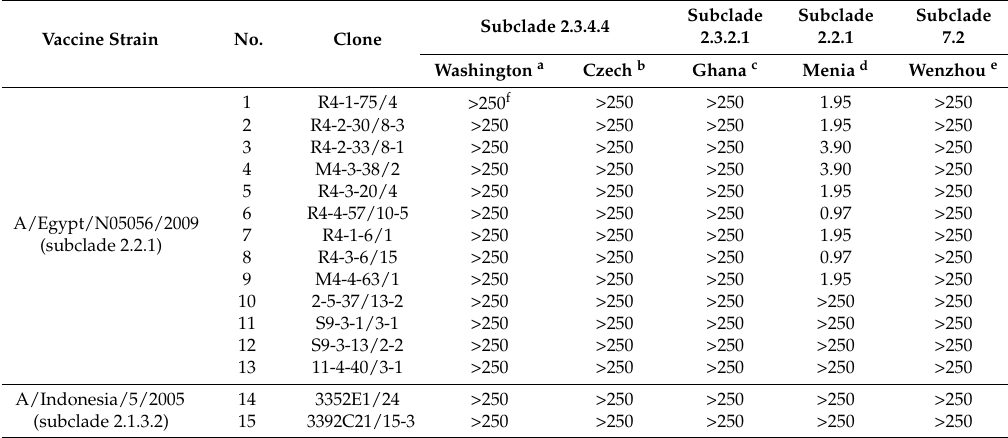
Table 4. HI activity of the human